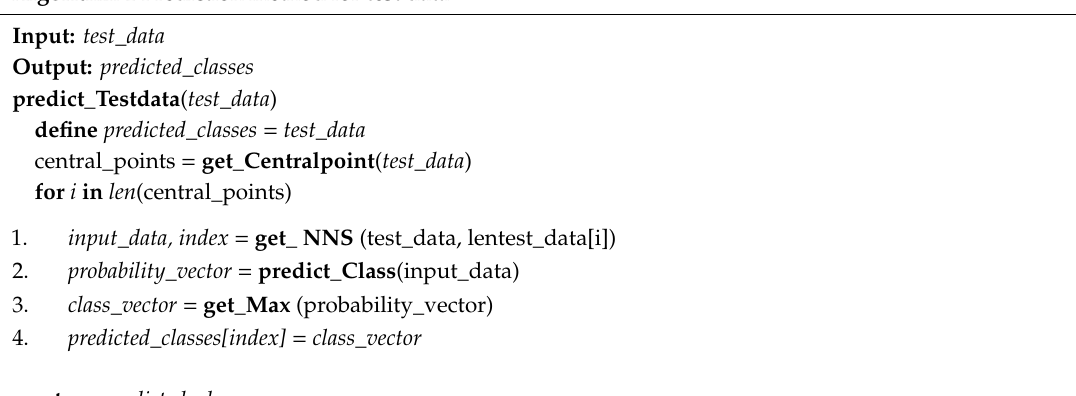
Algorithm 1 Prediction method for test data